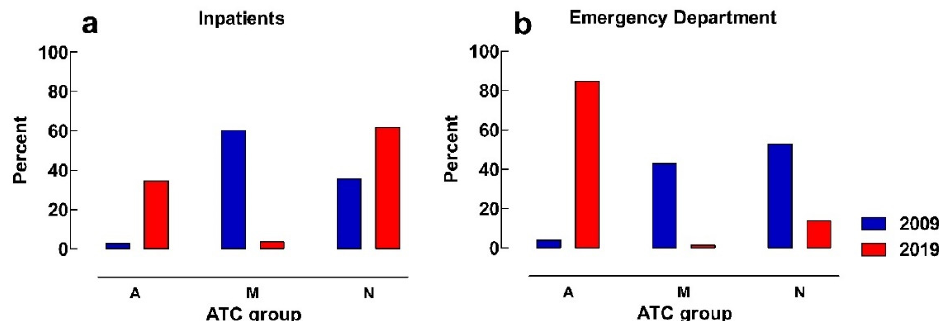
Figure 5. Percentage of the distribution of solid oral manipulations between different ATC-groups in: ( a ) inpatients, ( b ) emergency department; A = alimentary tract, M = musculoskeletal system, N = nervous system.